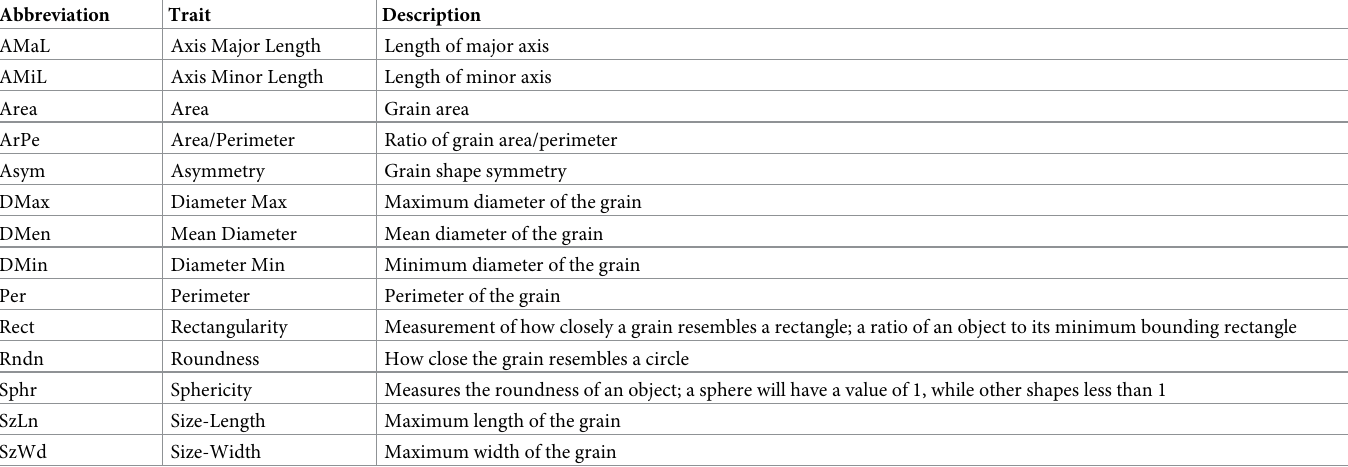
Table 1. Grain shape traits measured on wheat grain samples with the Acurum 1 grain